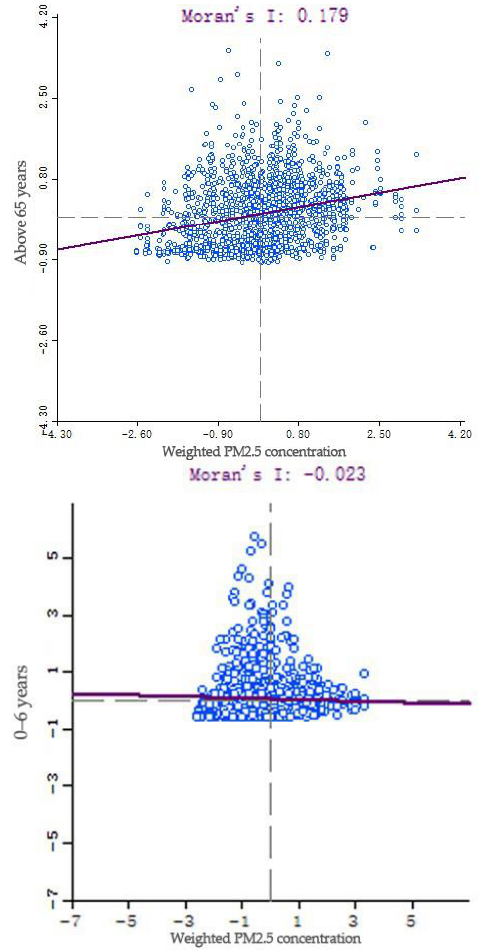
Figure 10. PM 2.5 – elderly people, children ’s Moran index. Figure 10. PM 2.5 –elderly people, children’s Moran